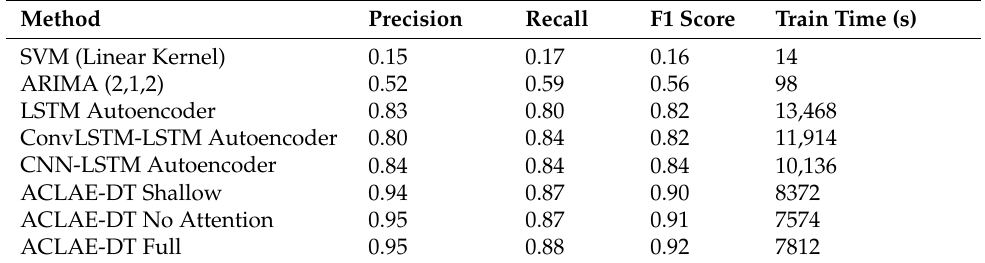
Table 2. Anomaly detection results using a window size of 10 with a step size of 2.